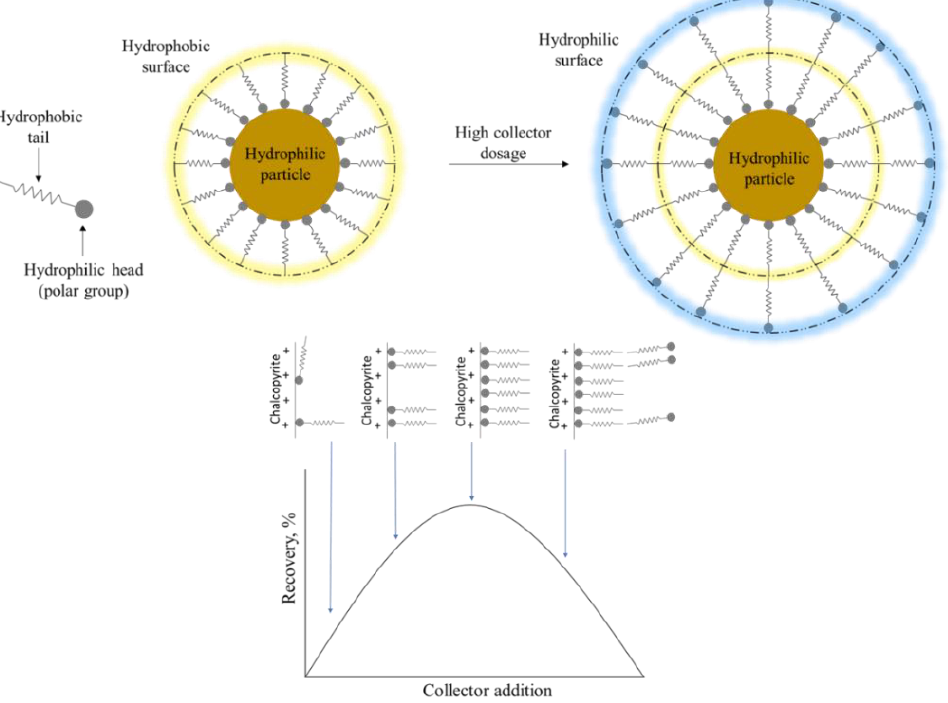
Figure 5. Schematic of the hydrophobic coating and how it affects the relationship between collector concentration and recovery.